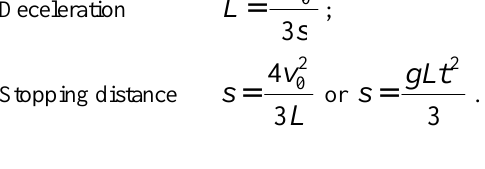
Fig 7. Rate of deceleration with a rectangular form When the rate of deceleration is triangular form No 1 (Fig 8):